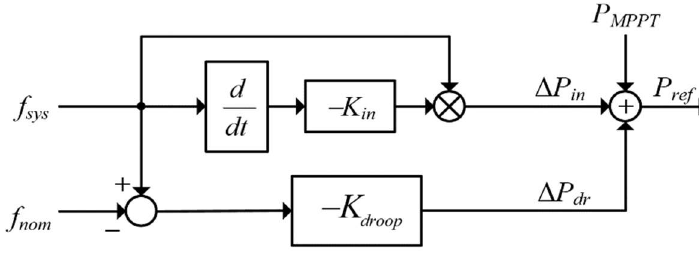
Figure 5. Structure of conventional scheme #1.